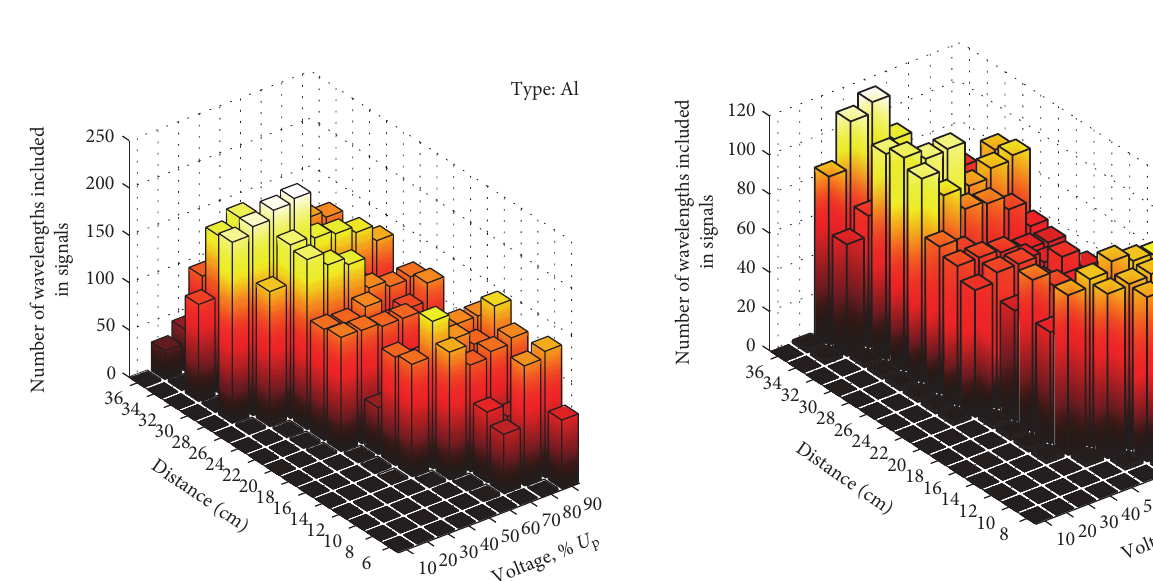
Figure 9: Dependency of voltage and distance on the number of wavelength components for the Al line.